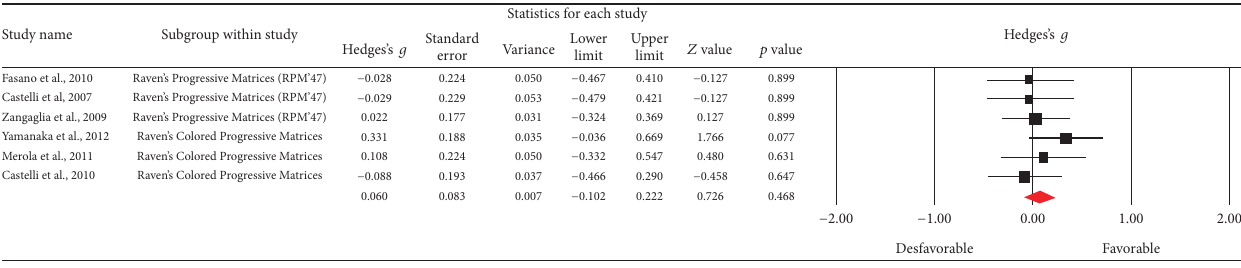
Figure 13: Meta-analysis of Raven Matrix comparing before and after DBS surgery.